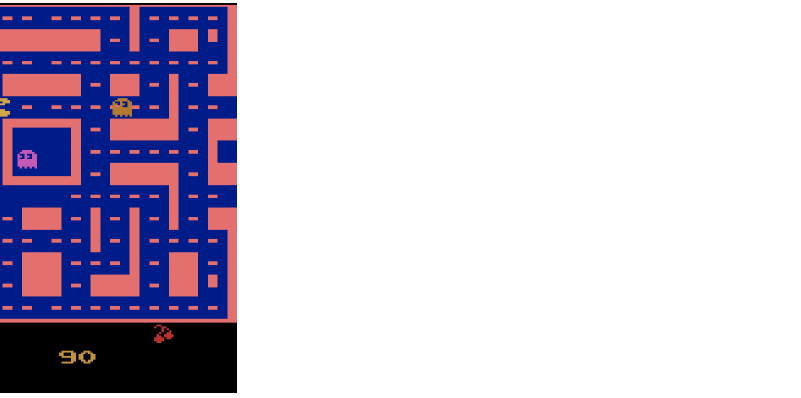
Figure 10. Game Ms. Pacman, in which Microsoft reached a high score in 2017, with 999,990 points, outperforming all the other human/computer high scores. Image taken using the OpenAI Gym Python package [47].